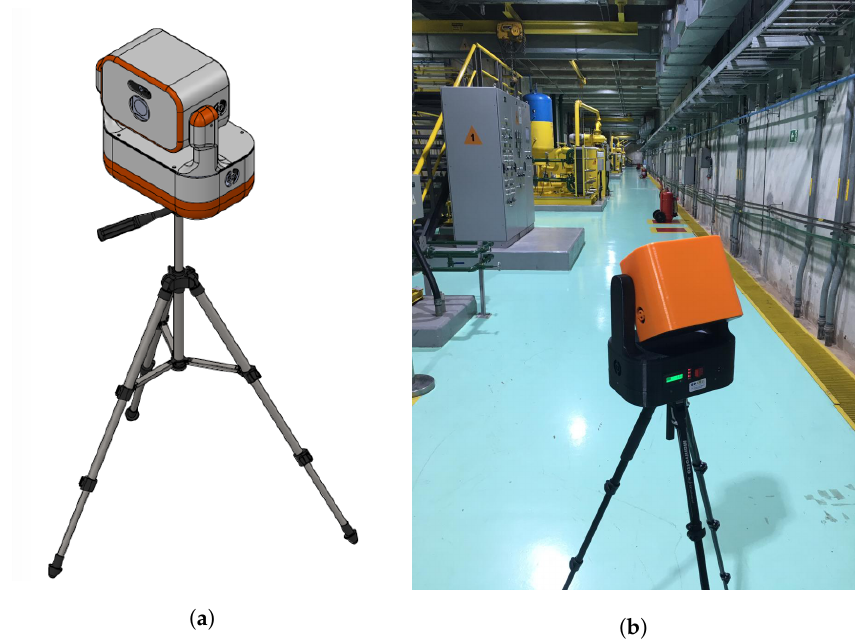
Figure 1. Implemented robot. ( a ) CAD drawing. ( b ) Robot at the power